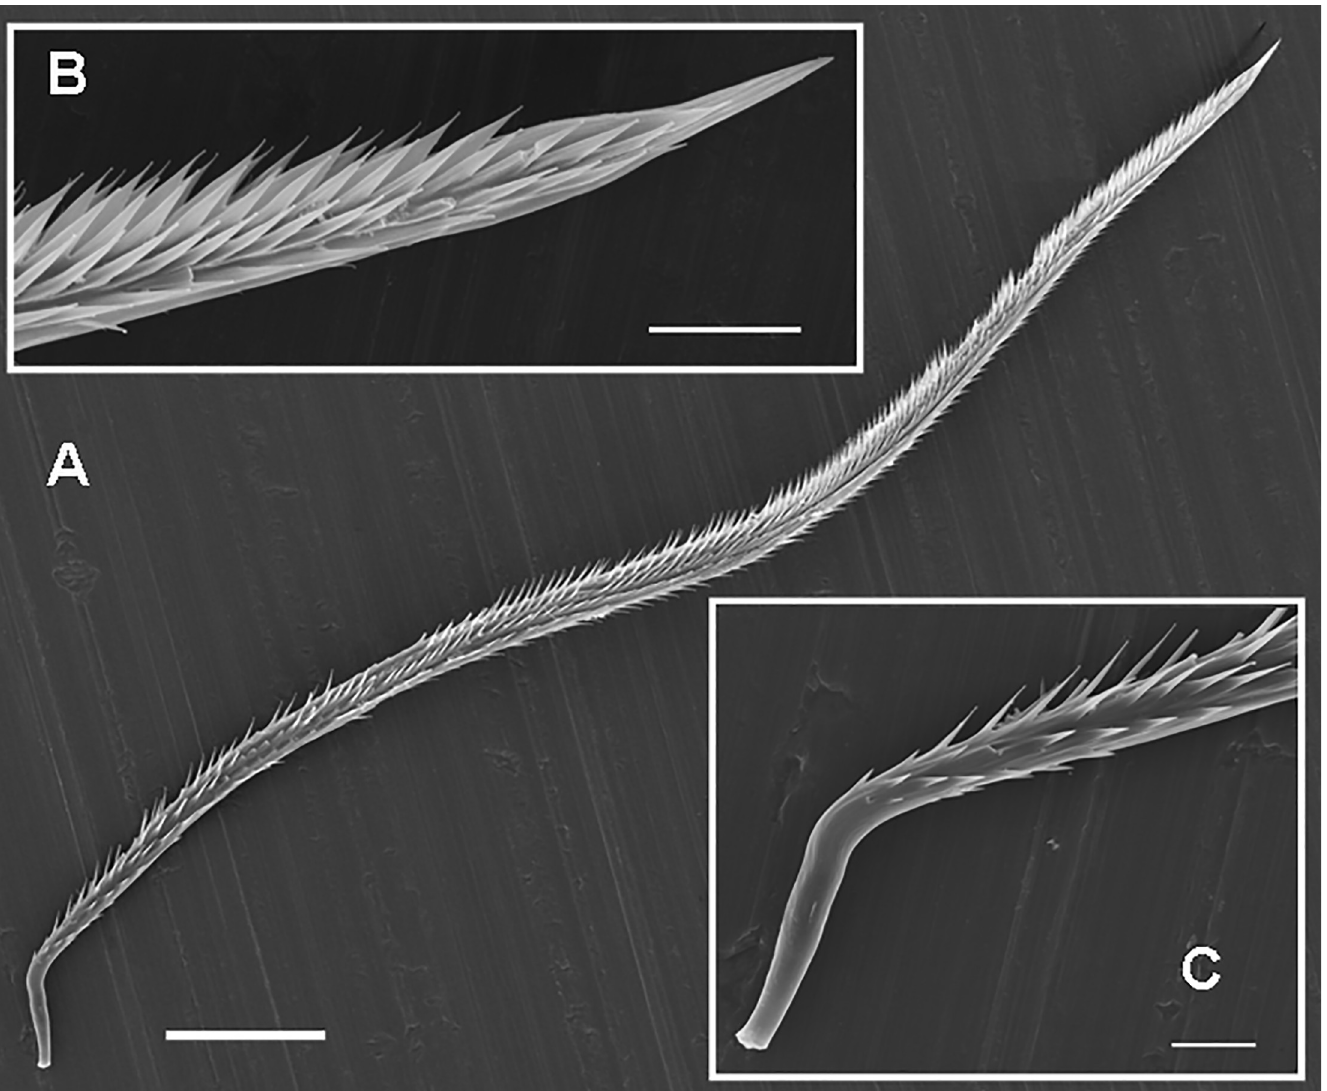
Fig 9. Urticating setae of type II and body seta of an immature female of Iridopelma hirsutum . (A) Type II, detail of the midsection. Scale bar = 5 μ m. (B) Body seta, detail of the midsection. Scale bar = 5 μ m. (C) Type II, detail of the basal section with a supporting stalk. Scale bar = 10 μ m.